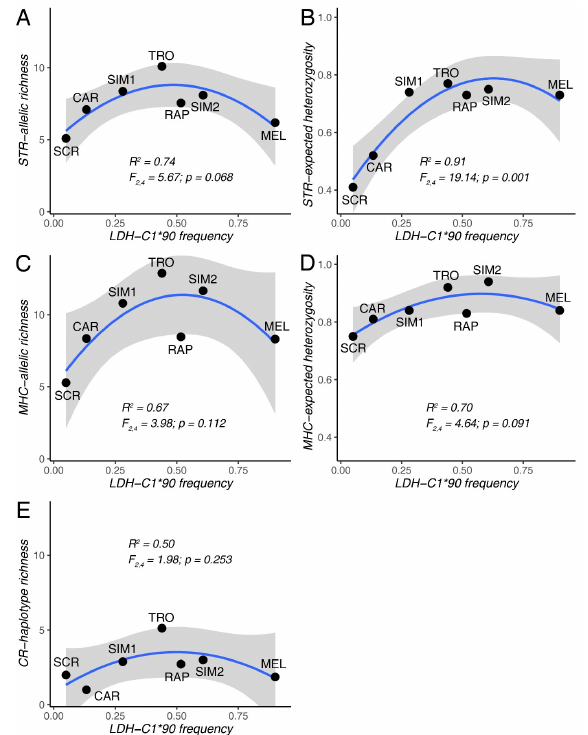
Figure 2. Second-order polynomial regression between the frequency of the domestic LDH-C1*90 allele and measures of genetic diversity (allele/haplotype richness, expected heterozygosity), based on 11 STR loci ( A , B ), the MHC- DAB gene ( C , D ), and the Control Region ( E ). For each model, the R- squared, the F-statistic, the p -value, and the 95% confidence intervals (in grey) are shown. Population abbreviations refer to Table 1.